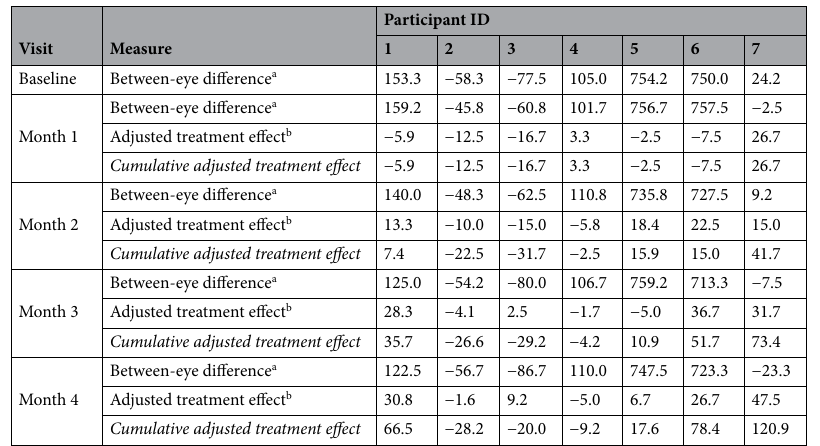
Table 3. Axial length at each study visit (in microns). a Calculated as treated eye minus control eye. b Calculated as between-eye difference at baseline minus the between-eye difference on visit. Values greater than zero indicate a positive treatment